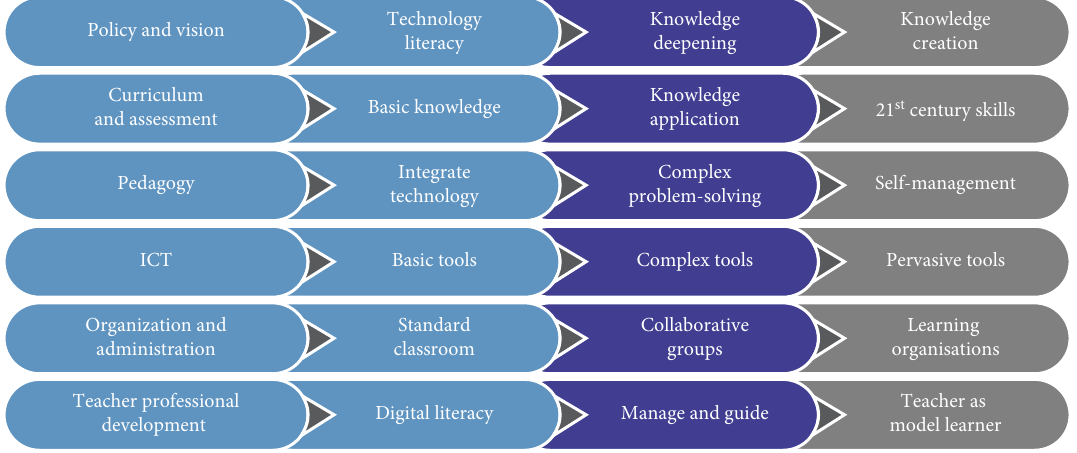
Figure 8: UNESCO ICT competency standards for teachers. Table 4: A summary of benefits of an ICT competency framework for teachers in Africa. Competency